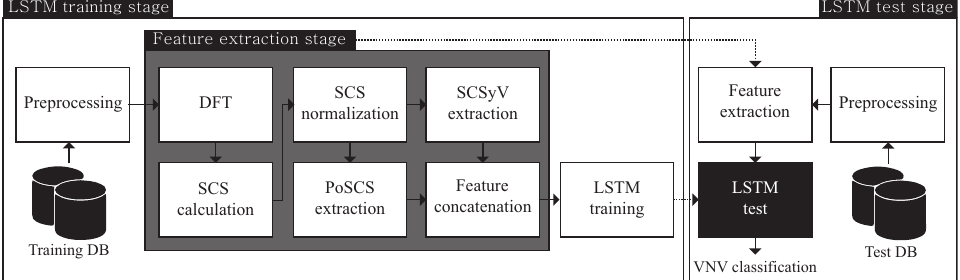
Figure 2. The block diagram for the LSTM-based VNVMC classification